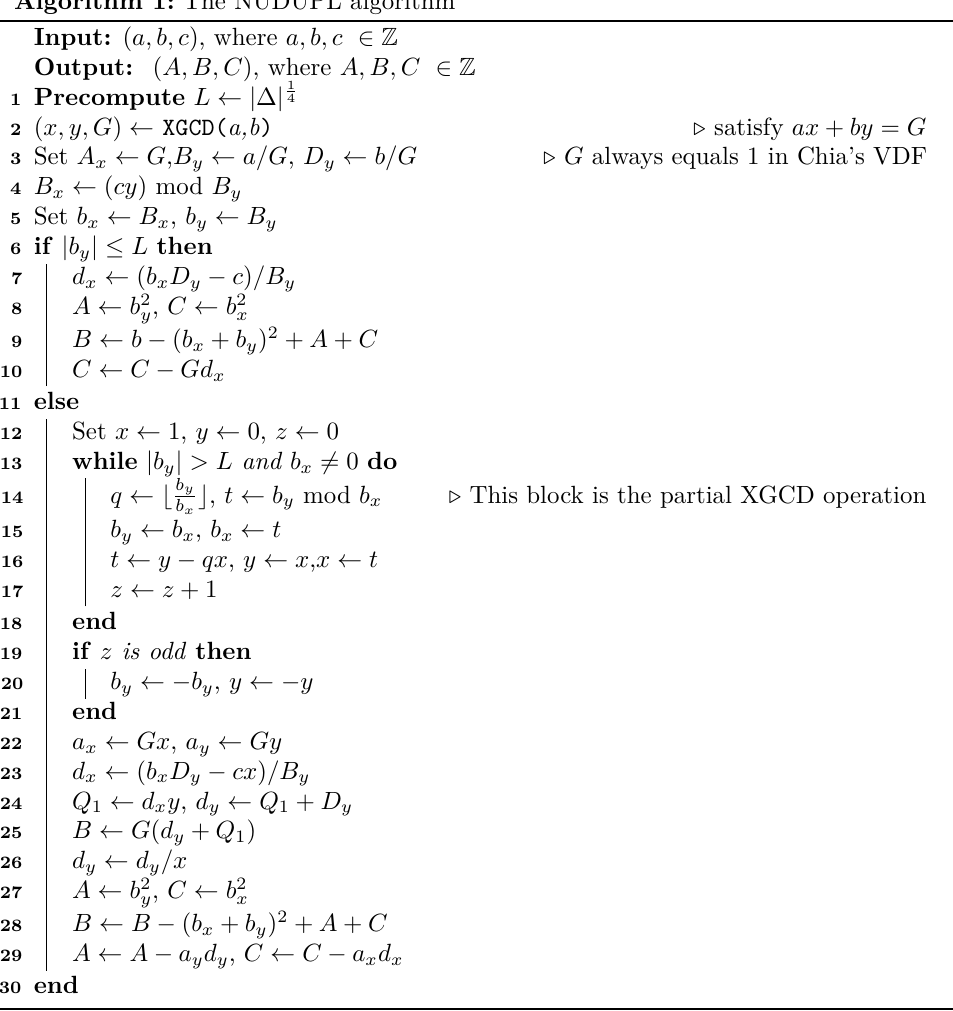
Algorithm 1: The NUDUPL